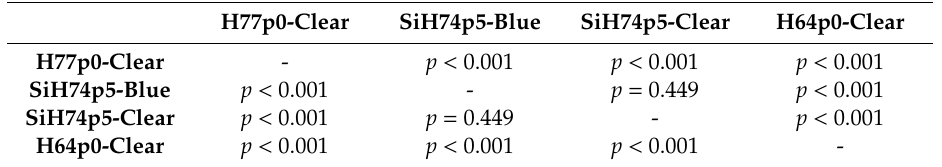
Table 3. Significance p-values for comparison between the experimentally measured Young’s moduli of each of the four tested materials. The results used to generate these values are presented in Figure 7. H77p0-Clear SiH74p5-Blue SiH74p5-Clear H64p0-Clear H77p0-Clear - p < 0.001 p < 0.001 p < 0.001 p < 0.001 - p = 0.449 p < 0.001 p <